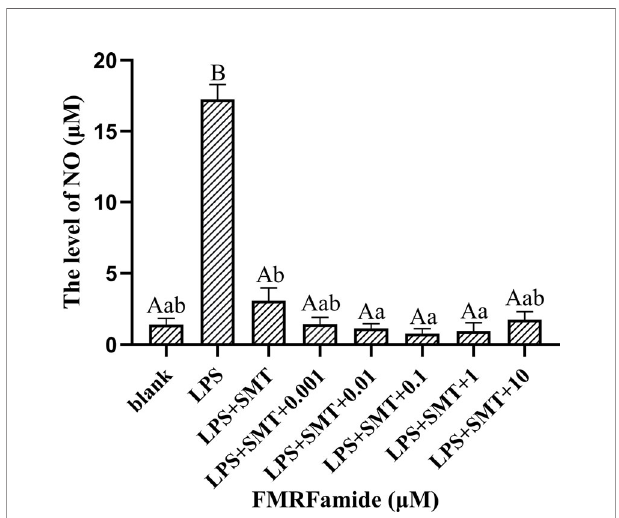
FIGURE 7 | Effect of co-stimulation of SMT and FMRFamide on NO under immune stress. The graphs display the mean ± SEM (n ≥ 3), and data were analyzed by one-way ANOVA followed by Dunnett ’ s post-hoc test. The different capital letters indicate a highly signi fi cant difference ( p < 0.01); different small letters indicate a signi fi cant difference ( p < 0.05); the same letter indicates no signi fi cant difference ( p > 0.05). SMT, S -methylisothiourea sulfate; NO, nitric